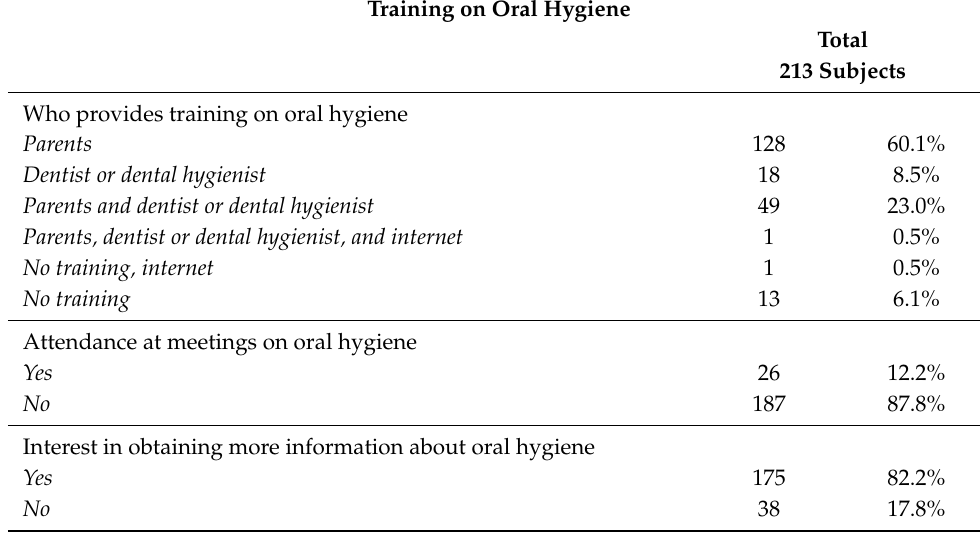
Table 4. Training on oral